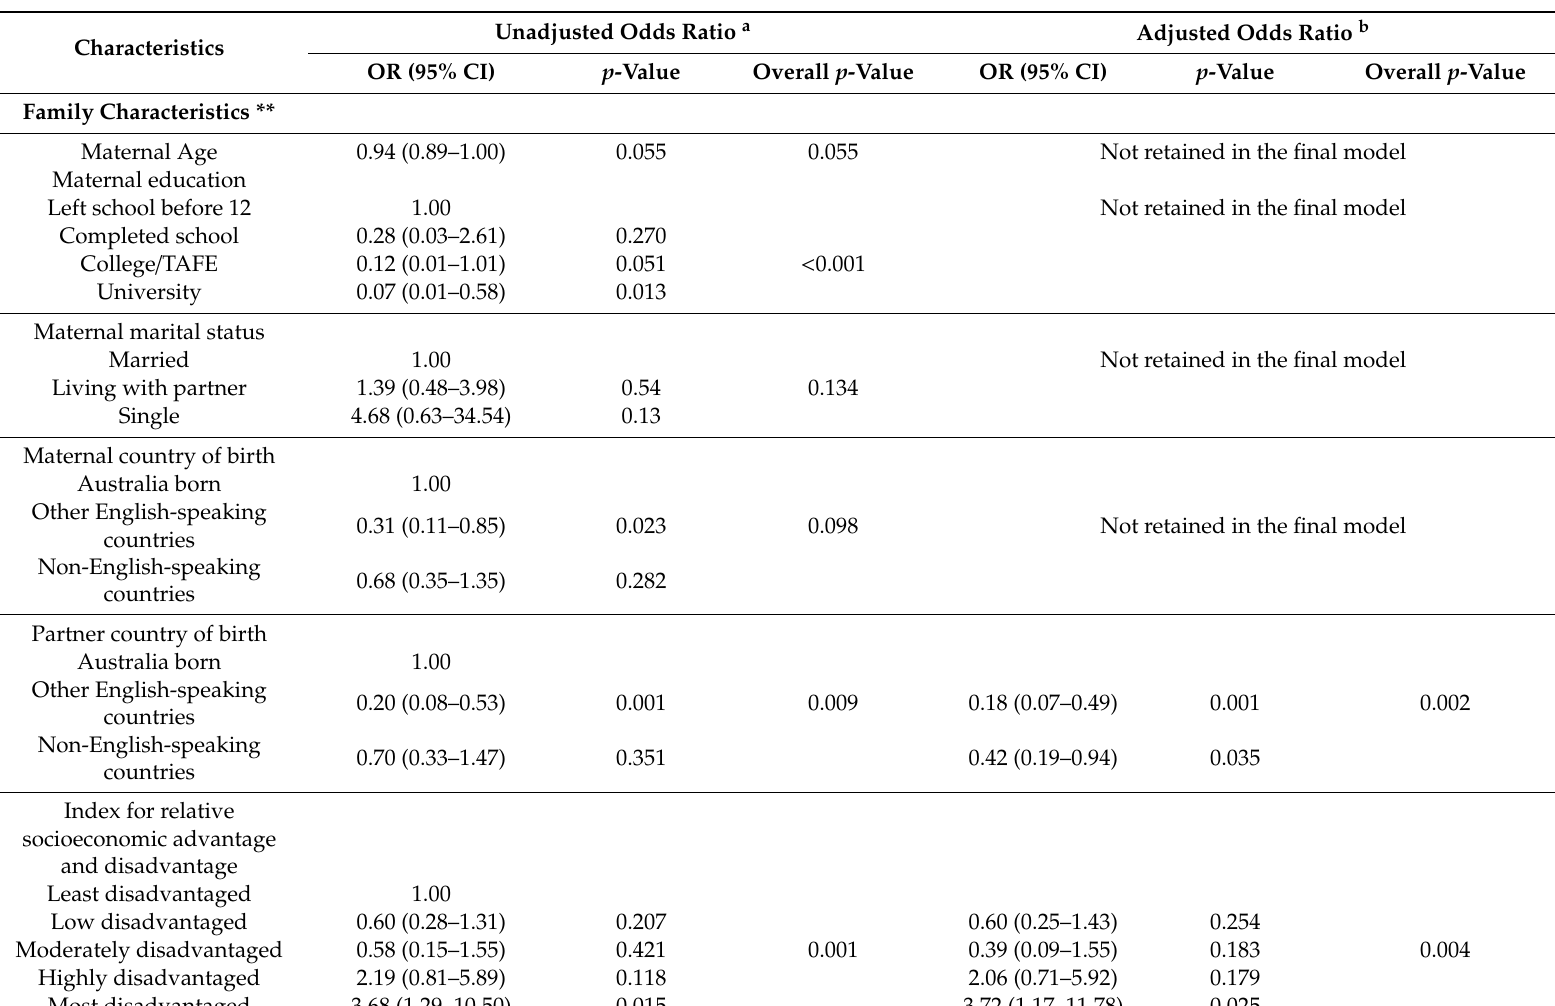
Table 3. Unadjusted and adjusted odds ratio for early introduction of discretionary foods ( < 52-weeks).